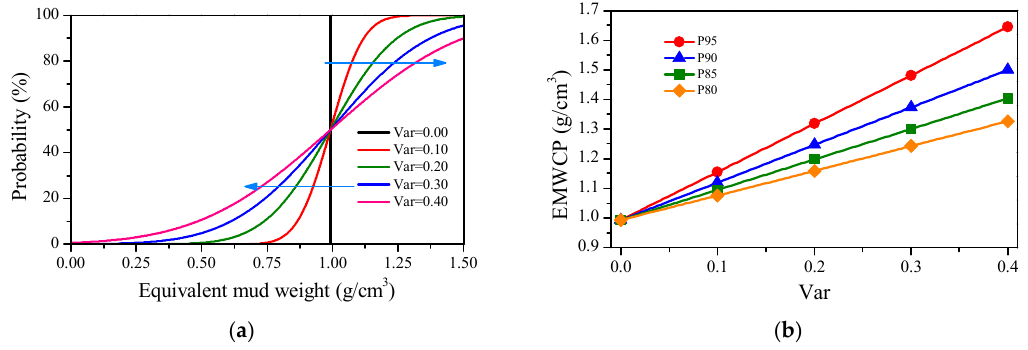
Figure 19. Influence of pore pressure variance on EMWPP. ( a ) Influence of variance of pore pressure; ( b ) EMWCP varies with variance.